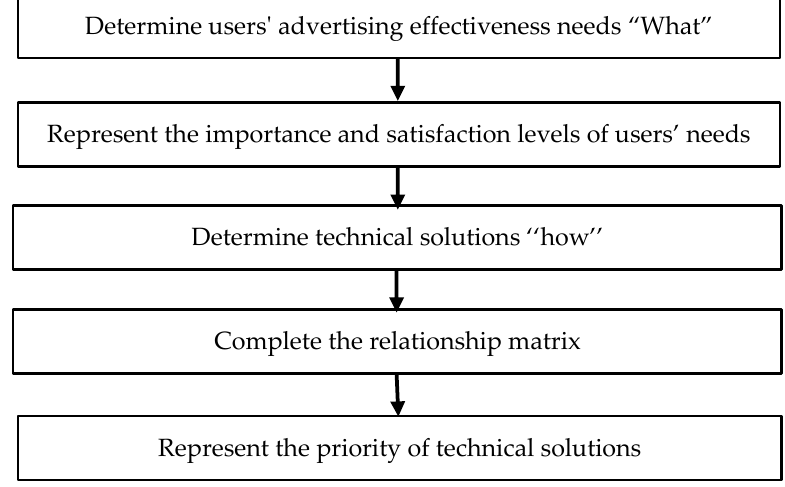
Figure 2. Framework of the proposed methodology.